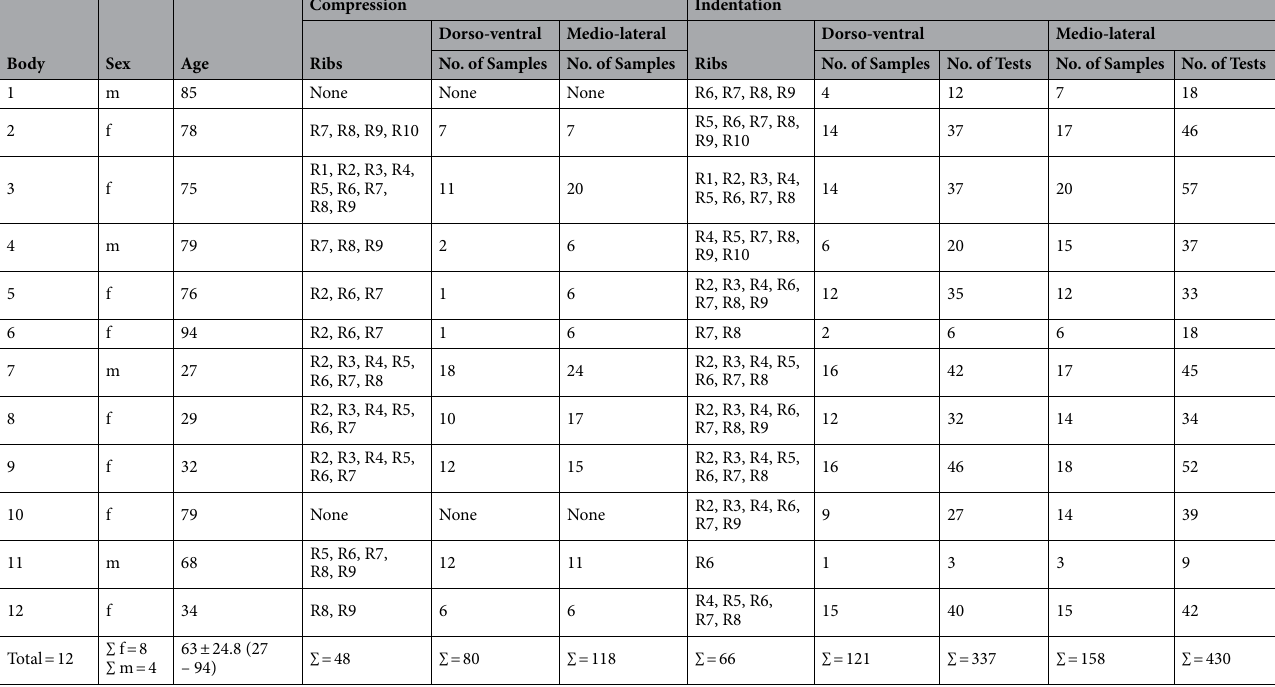
Table 1. Demographic variables of the cadavers and sample information. R = number of individual rib where sample was harvested; m = male, f = female; mean value (± standard deviation; minimum—maximum) of age is presented at the end of the table; ∑ =